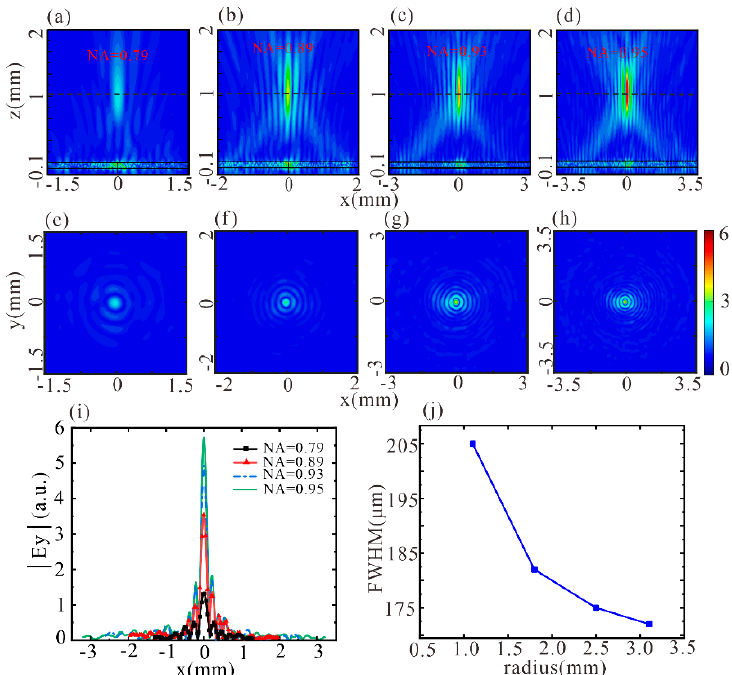
Figure 3. ( a – h ) Numerical results of the metalens with NA = 0.79, 0.89, 0.93 and 0.95, corresponding to r = 1135 μ m, 1877 μ m, 2515 μ m, and 3131 μ m, respectively. Electric field distributions with views on x–z and x–y planes are severally shown in ( a – d ) and ( e – h ). ( i ) The electric field distribu- tions along the x axis at the focal plane. ( j ) The relationship between FWHMs and r.